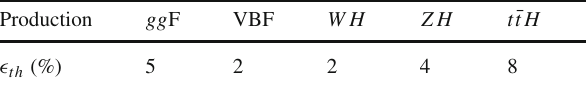
6. ATLASCollaboration,G.Aadetal.,SearchfortheStandardModel Higgs boson produced in association with top quarks and